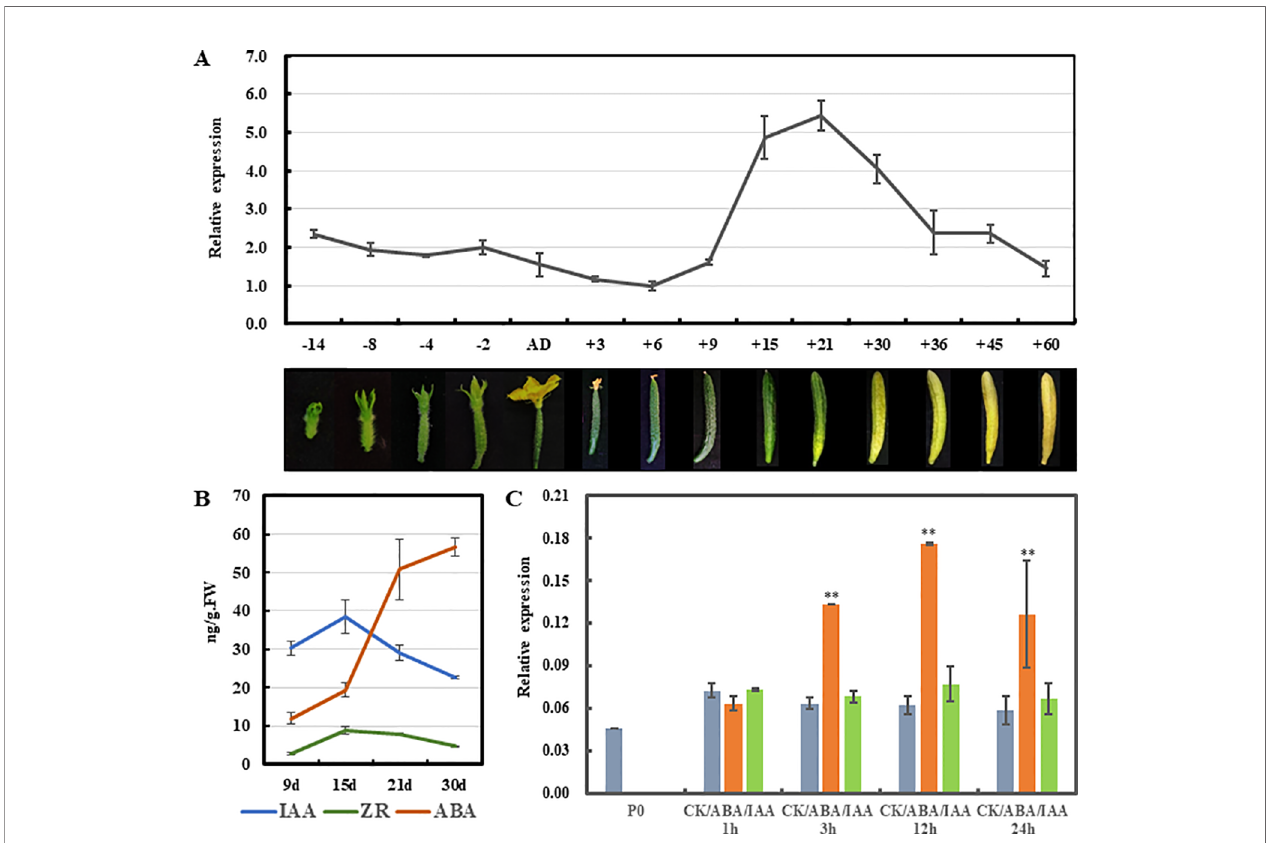
FIGURE 6 | Expression analysisof CsSHP duringfruitmaturation incucumber. (A) CsSHP expression infruits at different developmentalstages ininbred line R1461. Fruit pictures ofthe correspondingdevelopmentalstages are displayedatthe bottomin different proportions. (B) Measurements ofthreeendogenous hormones in fruitfrom9 to 30 daysafter anthesis(DAA). Three biological replicates were performed. (C) Expression response of CsSHP to abscisicacid (ABA) or indole-3-aceticacid (IAA) treatment in cucumber ovaries of 4 daysbefore anthesis. Threebiological replicates and three technical replicates were performed **, t-test (p<